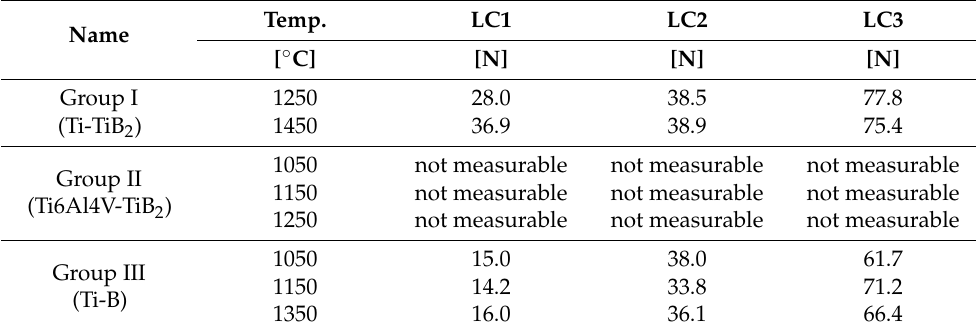
Table 2. Scratch test results for AlCrN coating (progressive load from 0 to 100 N, incremental loading rate of 10 N/mm, 10 mm/min scratch speed, and 10 mm scratch length).